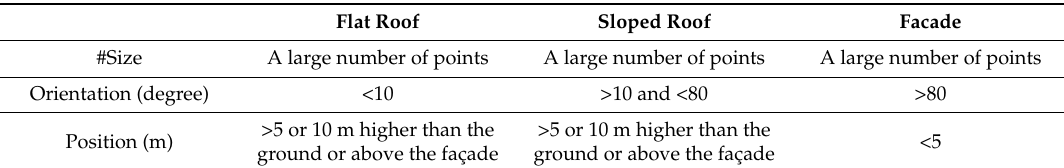
Table 1. Geometric features of flat roof, sloped roof, and